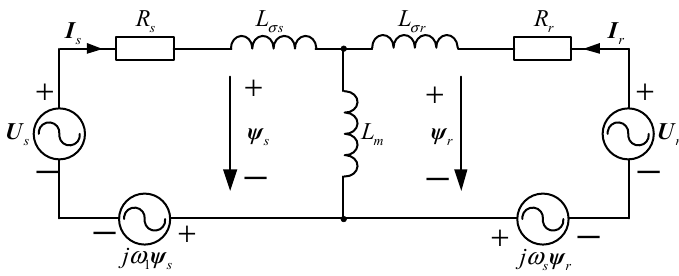
Figure 2. Equivalent T circuit diagram of DFIG.